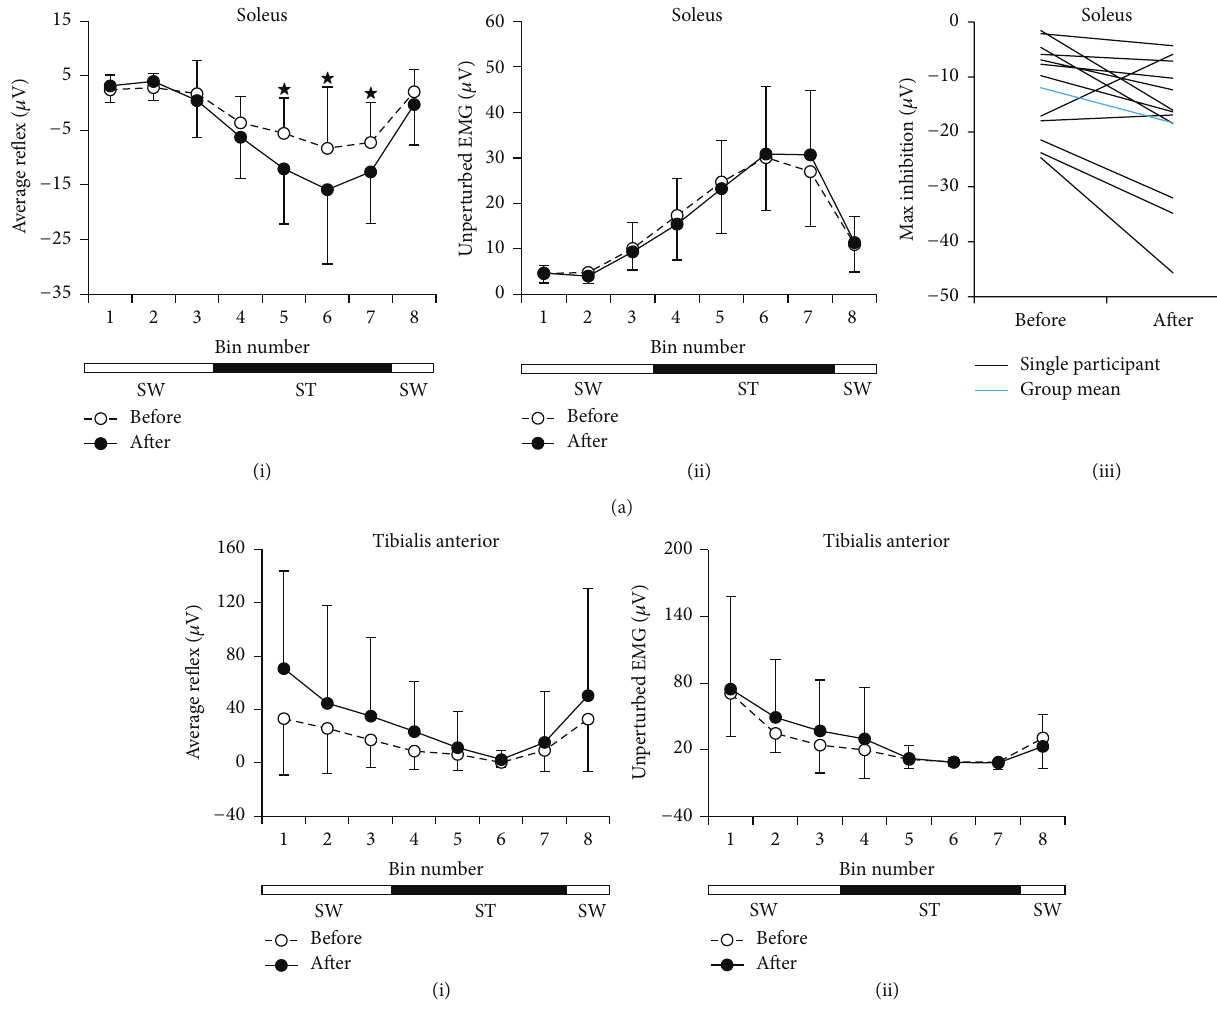
Figure 3: Changes in reflex excitability during walking varied with training type. The cutaneomuscular reflex (CMR) during 8 bins in the walking cycle, averaged across participants ( 𝑛 = 12 ), are shown for the soleus (a)(i) and tibialis anterior (b)(i) muscles before and after Endurance Training. Significant differences in post hoc comparisons are indicated with ‰ . Average EMG corresponding to the bin numbers during unperturbed walking trials are shown in (a)(ii) and (b)(ii). Error bars represent one standard deviation. ST: stance phase (solid bars); SW: swing phase (open bars). (a)(iii) Maximum (Max) inhibition of the SOL CMR before and after Endurance Training is shown for each participant, with the group mean